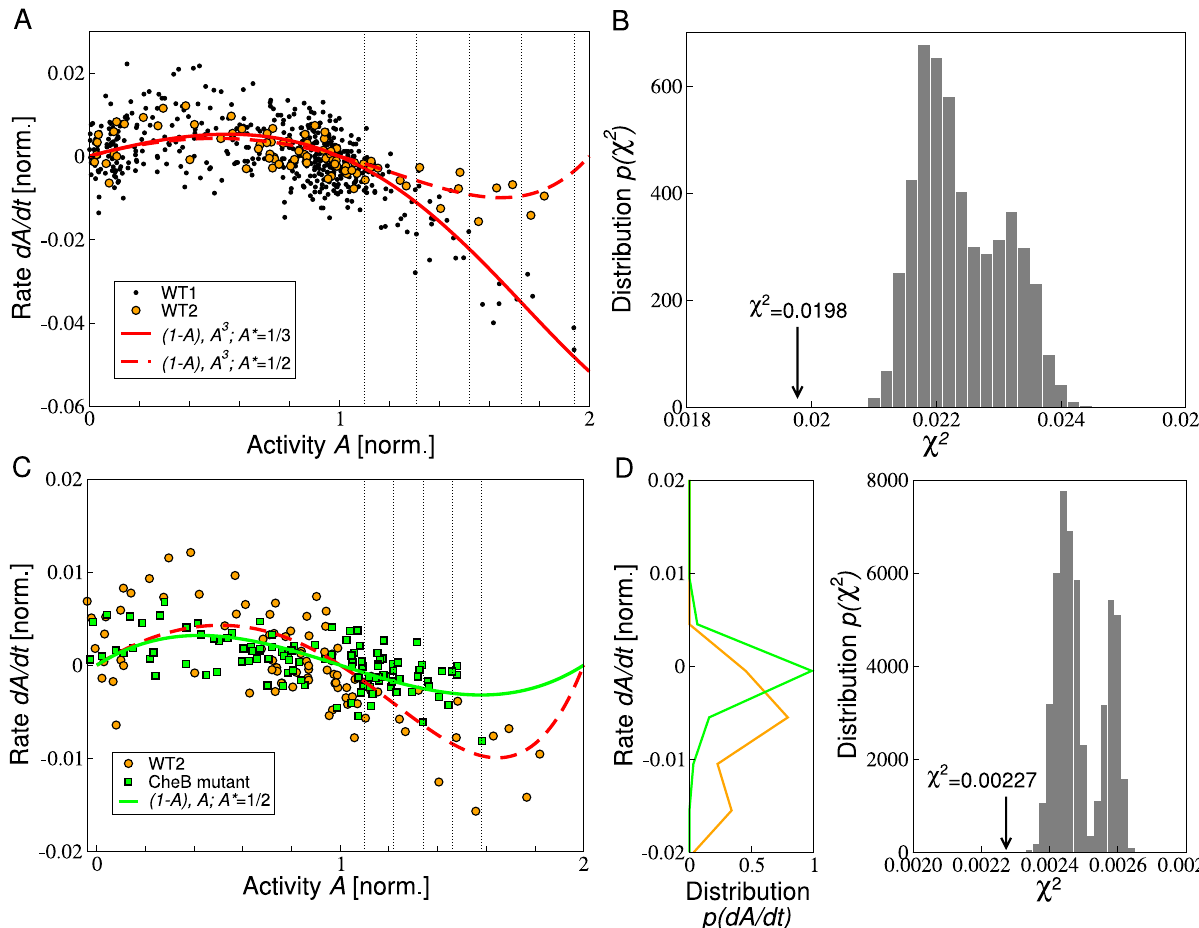
Figure 5. Effects of (A) steady-state activity and (C) CheB regulation by phosphorylation. (A) Black and orange dots correspond to the rate of FRET activity change from experimental time-course data for WT1 (Fig. 4) and for WT2 (addition and subsequent removal of concentration step change D c ~ 0 : 03mM at zero ambient concentration), respectively. Red lines correspond to the predicted rate of activity change dA = dt ~ f A ð Þ purely from adaptation (solid and dashed lines correspond to steady-state activities A (cid:2) & 1 = 3 and 1 = 2 , respectively). The methylation rate constant g R ~ 0 : 0019s { 1 is the same in each case. Dotted lines indicate bins used to quantify the difference between data sets in panel B. (B) Distribution of squared errors x 2 (cid:5) (cid:6) between predicted rate of activity change and experimental data sets for WT1 and WT2, when randomly permuting 10 4 pairs of data points between the data sets, one pair chosen within each bin in panel A. The error is calculated as the sum of errors for each data set (including the permuted data points) against its respective model. The error of the unpermuted data sets is indicated by the arrow. (C) Green squares represent the rate of FRET activity change from experimental time-course data for CheB mutant (addition and subsequent removal of concentration step changes D c ~ 0 : 03mM and 0.1 mM at zero ambient concentration). The green line represents the rate of change of receptor complex activity purely from adaptation. Orange dots and red dashed line are the same as in panel A. Dotted lines indicate bins used to quantify the difference between data sets in panel D. (D, left) Distribution of data points of the rate of activity change for activities above A ~ 1 : 1 WT2 and CheB mutant data in panel C. (D, right) Distribution of squared errors between predicted rate of activity change and experimental data sets for WT2 and CheB mutant, when randomly permuting 10 4 pairs of data points between the data sets, one pair chosen within each bin in panel C. The error is calculated as the sum of errors for each data set (including the permuted data points) against its respective model. The error of the unpermuted data sets is indicated by the arrow.